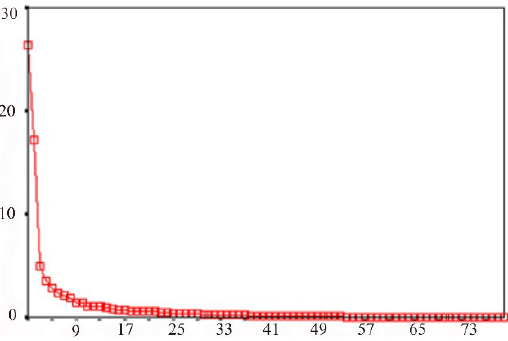
Figure 6. Scatter plot of factor analysis of the spectral power of the main EEG rhythms. Note: on the ordinate—the value of the factor; on the abscissa—the number of the factor. Note: explanations in the text.